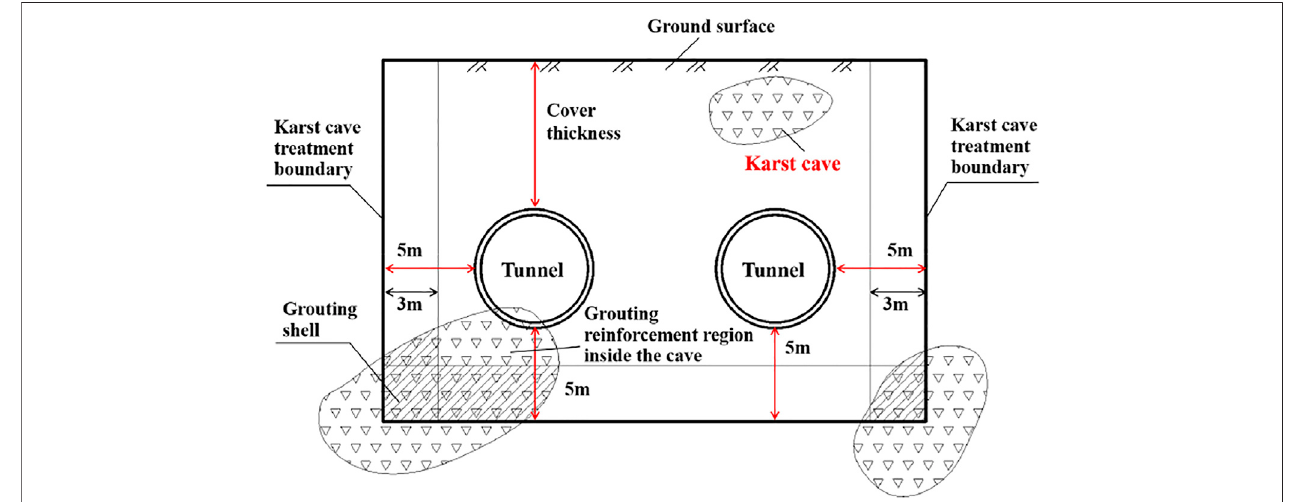
FIGURE 11 | Karst cave treatment scope.